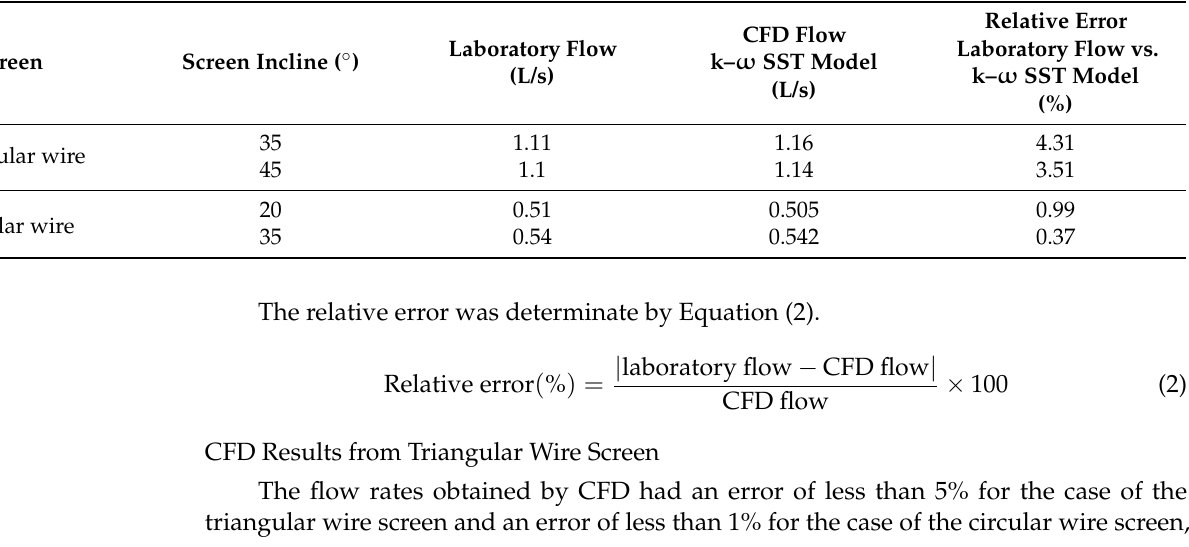
Table 7. Comparison of the Flow Obtained with Experimental Data vs. Numerical